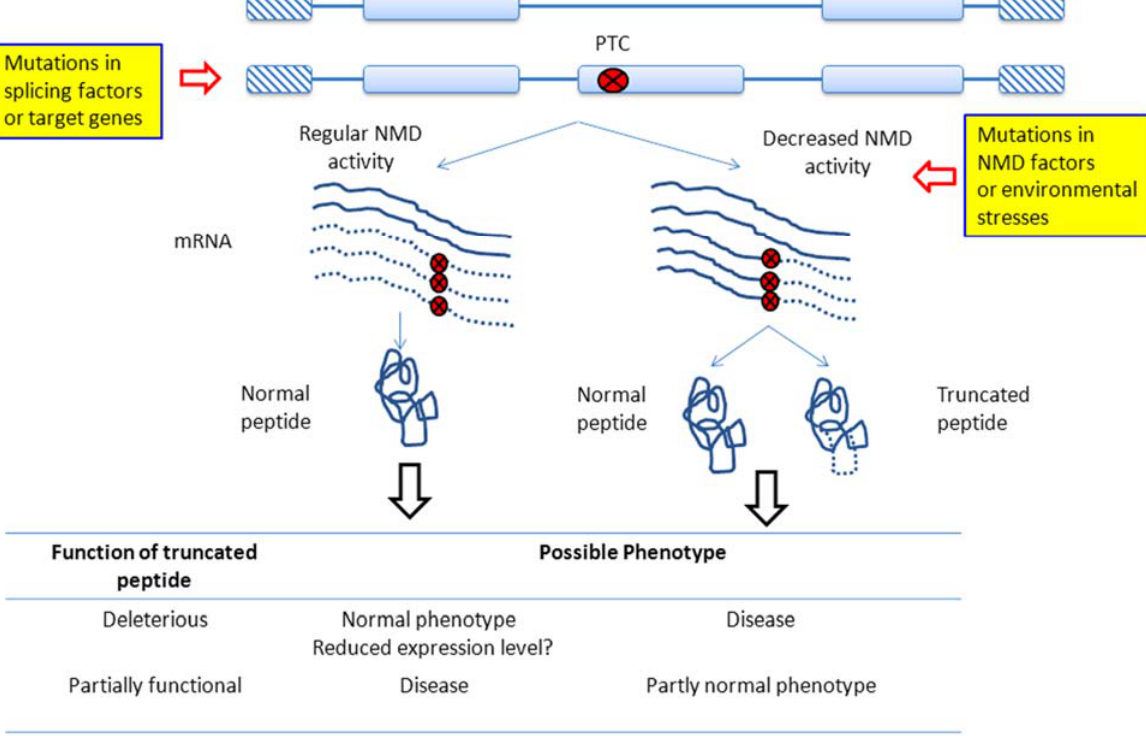
Figure 3. Possible outcomes of AS-NMD dysregulation. Misregulations of AS-NMD may occur because of mutations in the splicing factors or the genes of interest, which can lead to changes in the proportion of NMD-sensitive transcripts and subsequently the overall gene expression level ( left pathway). Alternatively, aberrant AS-NMD can occur because of mutations in the NMD regulators. The resulting decreases in NMD activity cause truncated peptides to accumulate in the cell ( right pathway). Generally, truncated peptides are detrimental and potentially pathogenic. However, in cases where truncated peptides are partially functional, decreases in NMD activity may turn out to be beneficial ( bottom panel). The dashed curves indicate that the mRNA sequences are not